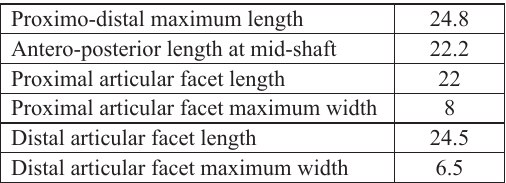
Table 1. Dimensions (in cm) of the shastasaurid radius (NMW95.61G.1) from the Lower Jurassic of Penarth,